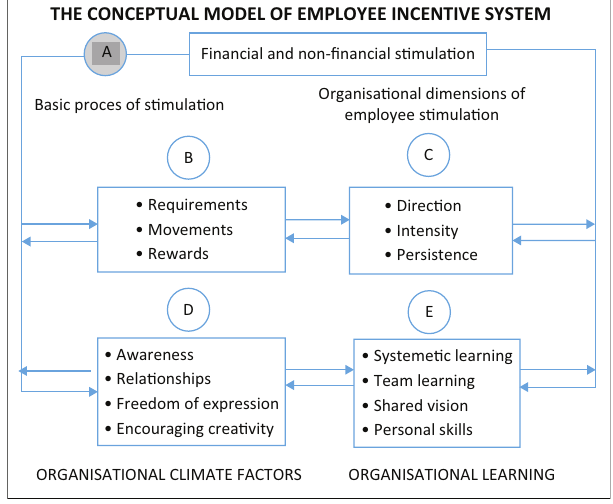
FIGURE 1: The conceptual model of an incentive system for